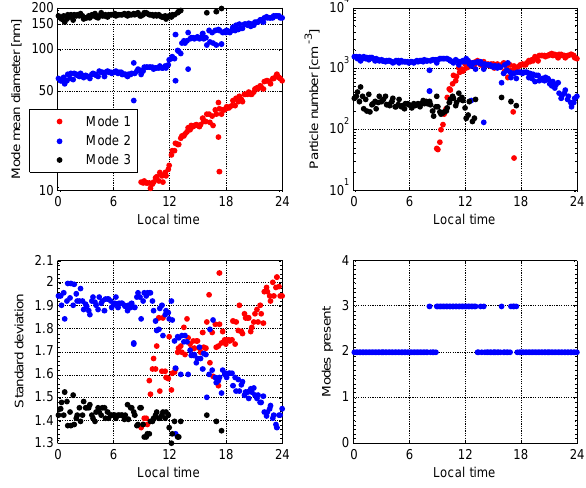
Fig. 5. Modal fit parameters for Botsalano median diurnal be- haviour.